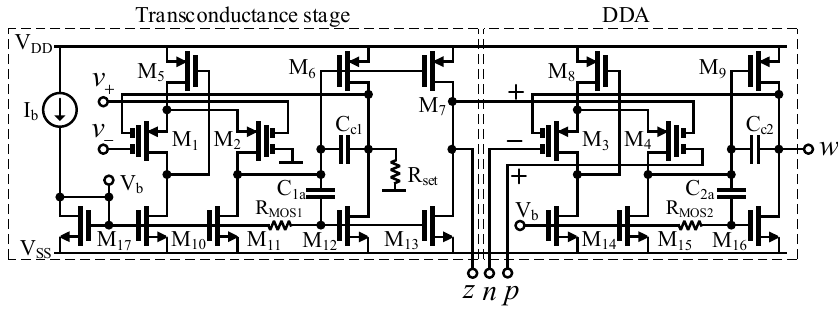
Figure 3. The CMOS structure of the VDDDA.